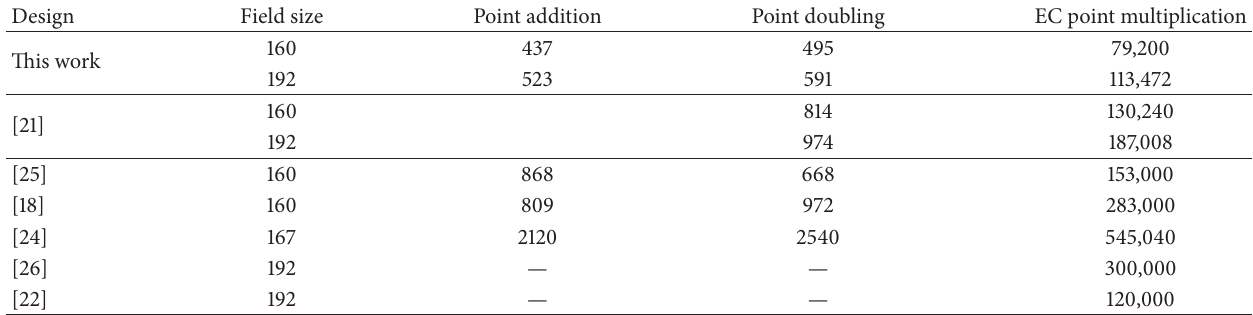
Table 4: Clock cycles requirements for different designs.